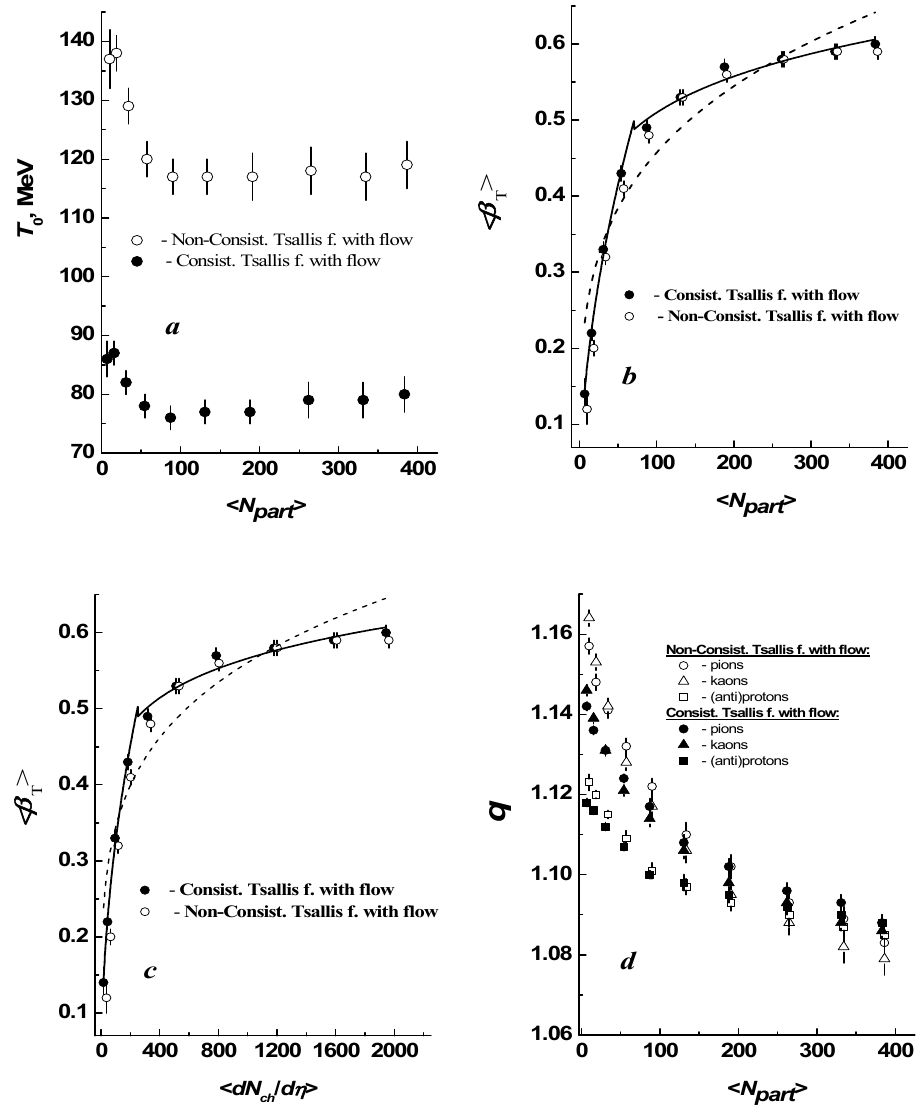
(cid:10) (cid:11) N part Figure 3. The dependencies of the obtained T 0 ( a ) and (cid:104) β T (cid:105) ( b ) parameters ( • ) of consistent Figure 3. The 〈𝑁 (cid:3043)(cid:3028)(cid:3045)(cid:3047) 〉 dependencies of the obtained T 0 ( a ) and 〈𝛽 (cid:3021) 〉 ( b ) parameters ( ● ) of consistent Tsallis function with transverse flow (Equation (5)), presented in Table 2, in Pb + Pb collisions at Tsallis function with transverse flow (Equation (5)), presented in Table 2, in Pb + Pb collisions at √ (cid:10) (cid:11) s nn = 5.02 TeV; ( c ) the (cid:104) β T (cid:105) versus (cid:104) dN ch / d η (cid:105) dependence; ( d ) the N part dependence for the (cid:3493) 𝑠 (cid:3041)(cid:3041) = 5.02 TeV; ( c ) the 〈𝛽 (cid:3021) 〉 versus 〈𝑑𝑁 (cid:3030)(cid:3035) /𝑑  〉 dependence; ( d ) the 〈𝑁 (cid:3043)(cid:3028)(cid:3045)(cid:3047) 〉 dependence for the ex- Figure 1. The obtained fit curves by consistent Tsallis function with transverse flow (Equation (5)) tracted q values of consistent Tsallis function with transverse flow (Equation (5)), presented in Table extracted q values of consistent Tsallis function with transverse flow (Equation (5)), presented in of the experimental midrapidity transverse momentum spectra of the charged pions ( ● ), kaons ( Δ ), 2, for the charged pions ( ● ), kaons ( ▲ ), and protons and antiprotons ( ▪ ). The results (Table 3) ob- and protons and antiprotons ( ▪ ) in Pb + Pb collisions at (cid:3493)𝑠 (cid:3041)(cid:3041) = 5.02 TeV at various centralities: 0– Table 2, for the charged pions ( • ), kaons ( (cid:78) ), and protons and antiprotons ( ). The results (Table 3) √ tained for the respective particles in Pb + Pb collisions at (cid:3493)𝑠 (cid:3041)(cid:3041) = 5.02 TeV using non-consistent Tsallis 5% ( a ), 20 – 30% ( b ), 50–60% ( c ), and 80–90% ( d ). s nn = 5.02 TeV using non-consistent obtained for the respective particles in Pb + Pb collisions at function with transverse flow (Equation (4)) are plotted by the corresponding open symbols. The Tsallis function with transverse flow (Equation (4)) are plotted by the corresponding open symbols. dashed and solid curves in panels ( b , c ) are minimum 𝜒2 fits by the simple (single)-power (Equa- The dashed and solid curves in panels ( b , c ) are minimum χ 2 fits by the simple (single)-power tions (6) and (8)) and two-power (Equations (7) and (9)) functions, respectively, of the 〈𝛽 (cid:3021) 〉 versus (Equations (6) and (8)) and two-power (Equations (7) and (9)) functions, respectively, of the (cid:104) β T (cid:105) 〈𝑁 (cid:3043)(cid:3028)(cid:3045)(cid:3047) 〉 and 〈𝛽 (cid:3021) 〉 versus 〈𝑑𝑁 (cid:3030)(cid:3035) /𝑑  〉 dependencies, respectively, extracted using consistent Tsallis (cid:10) (cid:11) N part versus and (cid:104) β T (cid:105) versus (cid:104) dN ch / d η (cid:105) dependencies, respectively, extracted using consistent function with transverse flow. For better visibility, the data (open symbols), extracted using non- Tsallis function with transverse flow. For better visibility, the data (open symbols), extracted using consistent Tsallis function with transverse flow (Equation (4)), are slightly shifted along the positive non-consistent Tsallis function with transverse flow (Equation (4)), are slightly shifted along the directions of 〈𝑁 (cid:3043)(cid:3028)(cid:3045)(cid:3047) 〉 and 〈𝑑𝑁 (cid:3030)(cid:3035) /𝑑  〉 axes. (cid:10) (cid:11) N part positive directions of and (cid:104) dN ch / d η (cid:105) axes. Figure 3a,b demonstrate that parameter T 0 as well as (cid:104) β T (cid:105) , obtained using both consistent and non-consistent Tsallis functions with transverse flows, similarly depend (cid:10) (cid:11) N part on . Figure 3a shows that T 0 values obtained from combined fits by the consistent Tsallis function with a transverse flow (Equation (5)) are systematically smaller as